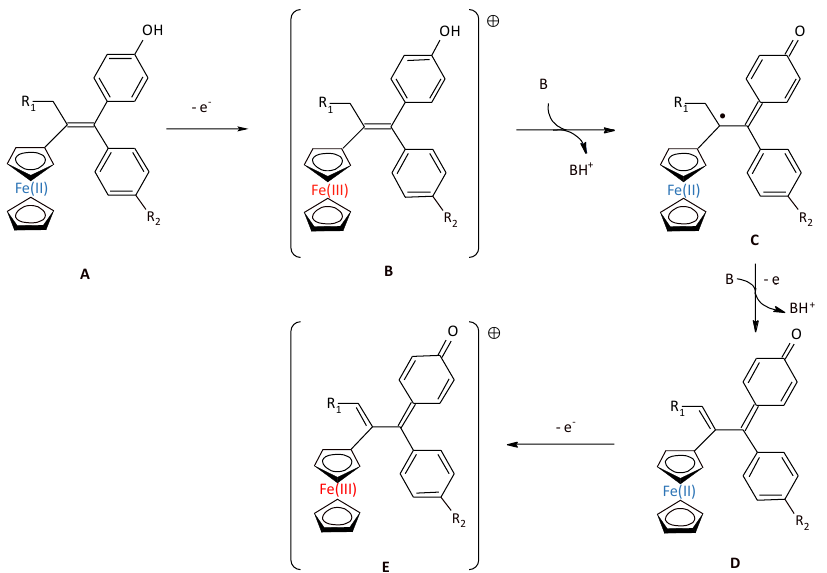
Scheme 2. General sequence proposed for the oxidation of ferrociphenols (ferrocifens having at least one phenol substituent) in the presence of a base (adapted from refs. [21,35]). The oxidized Fe(III) states are highlighted in red.